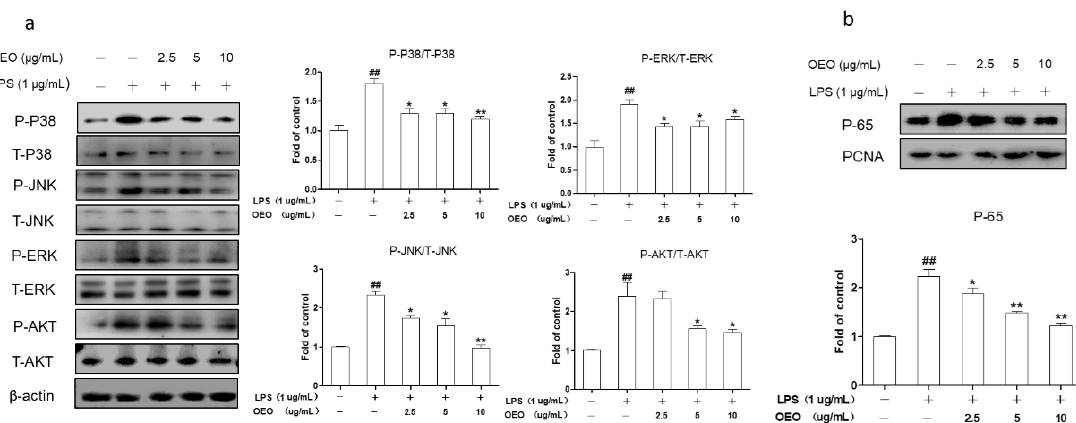
Figure 2. OEO inhibits LPS-induced AKT, MAPKs, and NF- κ B activation in the RAW264.7 cells. ( a ) Cells were pretreated with OEO for 12 h, then incubated with 1 µ g/mL LPS for 1 h. MAPKs and AKT were estimated by Western blot. ( b ) Cells were pretreated with OEO for 12 h, then incubated with 1 µ g/mL LPS for 1 h. Western blot results show the effects of OEO on the protein levels of NF- κ B p65 in the nuclear fractions. ERK1/2—extracellular signal-regulated kinases 1/2; JNK—c-Jun N-terminal protein kinase; P38—p38; Akt—protein kinase B; NF- κ B—nuclear factor kappa B; P—phosphorylated; T—total. Values represent means ± SEM, n = 3. # p < 0.05 and ## p < 0.01 compared to the control